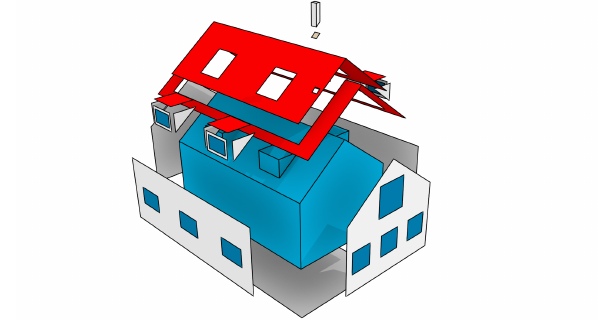
Figure 9: Two representations of LOD3 models: a gml:Solid and a thematically structured gml:MultiSurface . Note the ClosureSurface of the chimney (light brown) in order to sepa- rate the usable volume of a